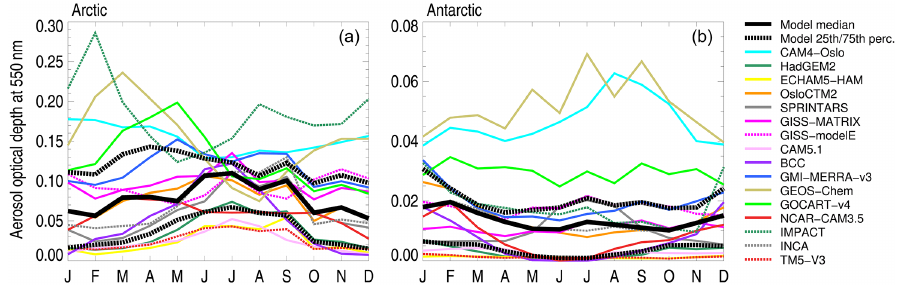
Figure 1. Mean seasonal cycle of the Arctic (60–90 ◦ N) (a) and Antarctic (70–90 ◦ S) (b) total AOD. The different colours represent the different AeroCom Phase II models. The black solid line is the model median and the dashed line is the 25th / 75th